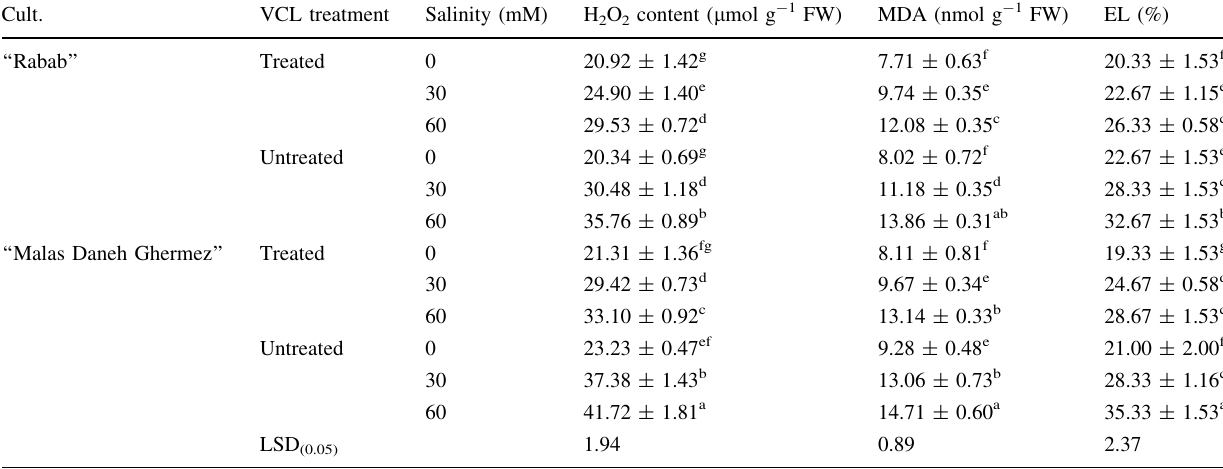
Table 4 Effects of VCL treatments on H 2 O 2 content, MDA, and EL of pomegranate seedlings under NaCl-induced salt stress Cult.